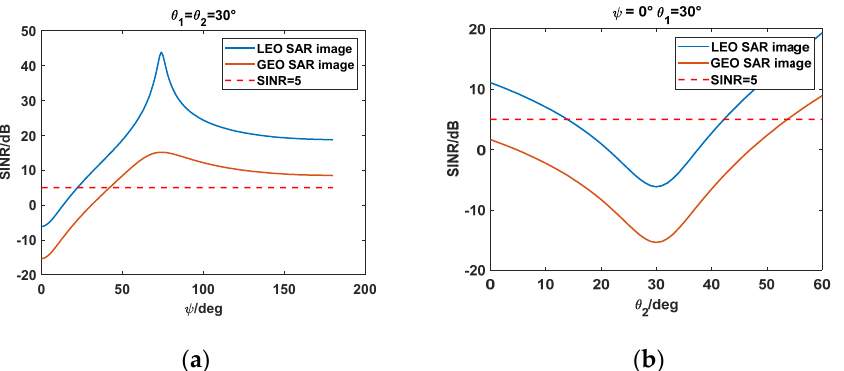
Figure 9. Image SINR, where the integration time of GEO SARs is 220 s and the integration time of LEO SARs is 0.5 s. The azimuth beamwidth of LEO SARs is 1.47 ◦ ; ( a ) θ 1 = θ 2 = 30 ◦ ; ( b ) ϕ = 0 ◦ , θ 1 = 30 ◦